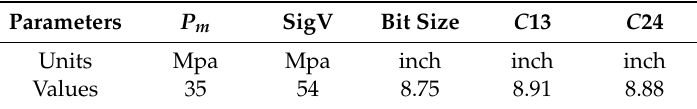
Table 1. Available known parameters.